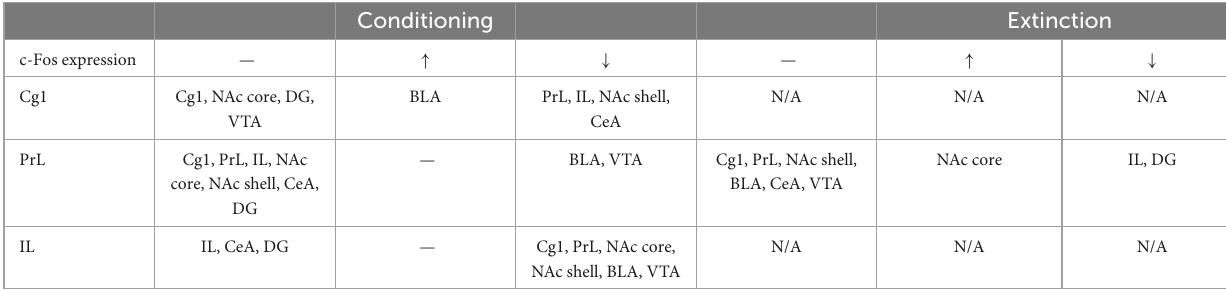
TABLE 4 c-Fos expression after morphine-induced aversive saccharin solution consumption suppression in conditioning and extinction following optogenetic ChR2 excitatory stimulation in the Cg1, PrL, and